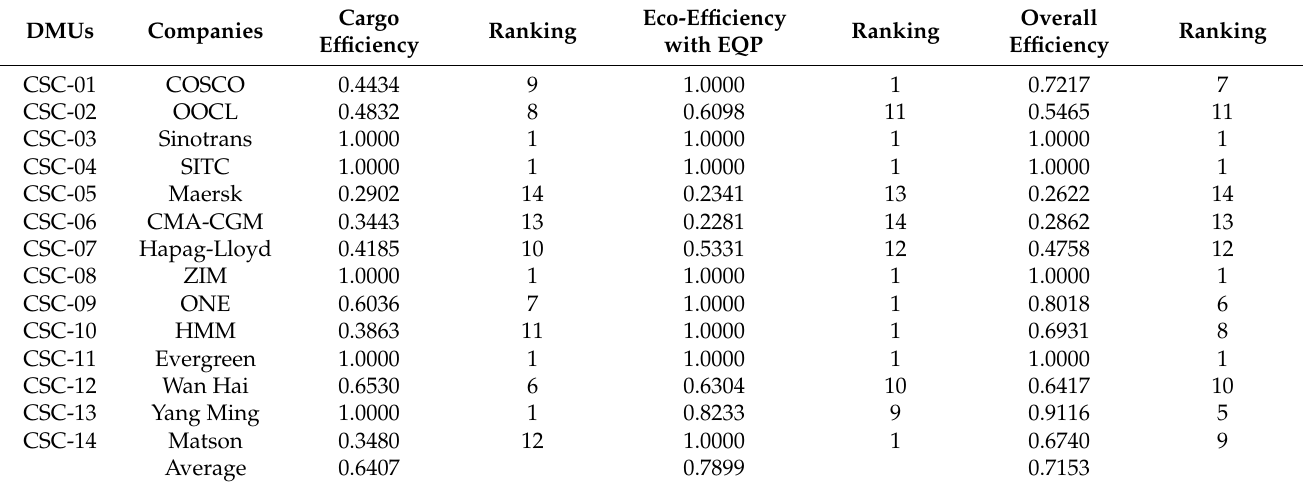
Table 16. Cargo and eco-efficiency of each CSC of the DEA model.